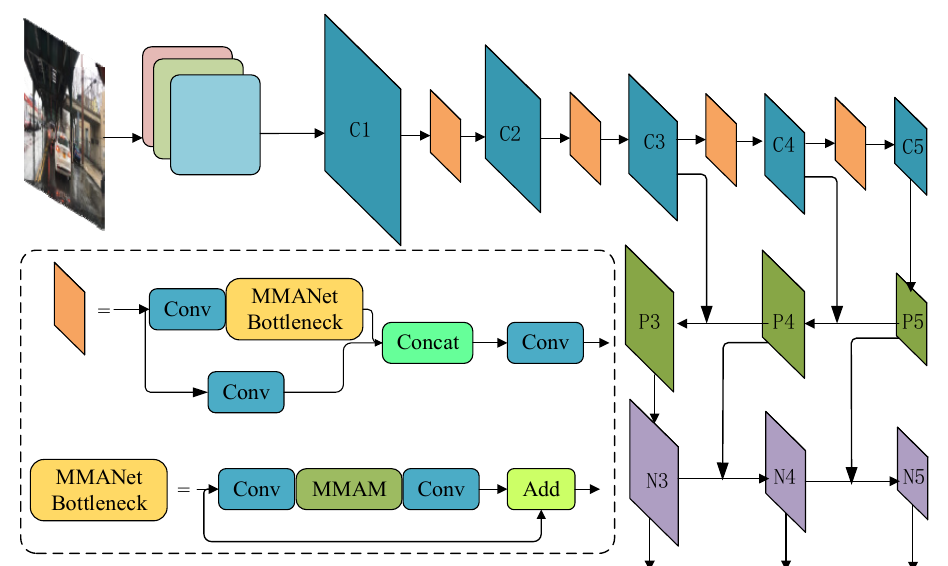
Figure 1. Architecture of proposed MHAM-YOLO network.